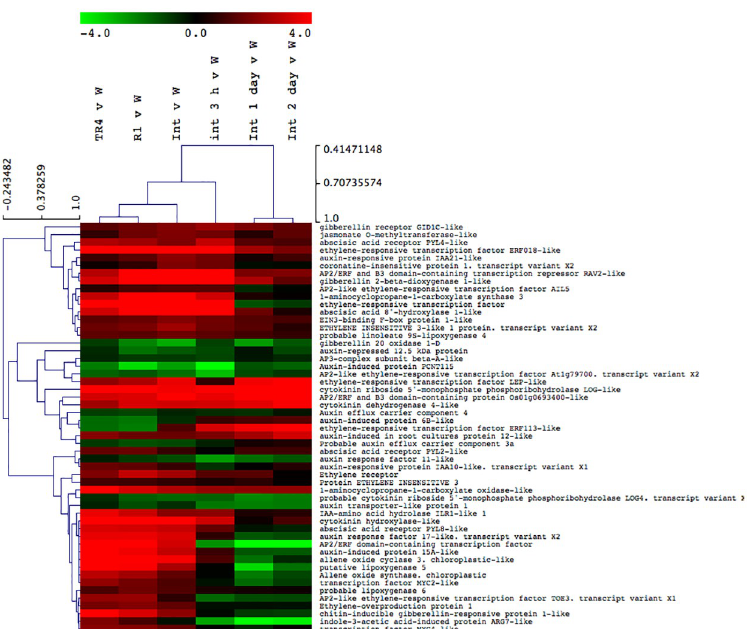
Fig 5. Transcriptional analyses of hormone response pathway related genes in the interactions between Cavendish ‘Grand Naine’ and R1, F . odoratissimum TR4 and the challenge inoculation R1 + TR4. Hierarchical clustering analysis of representative hormone response pathway. The heat plots represent significant (P < 0.05) average expression differences between the water control and TR4, R1 and R1 + TR4 at 0, 3 hours, 1 day and 2 days after inoculation. Bars represent upregulated genes (red) and downregulated genes (green).